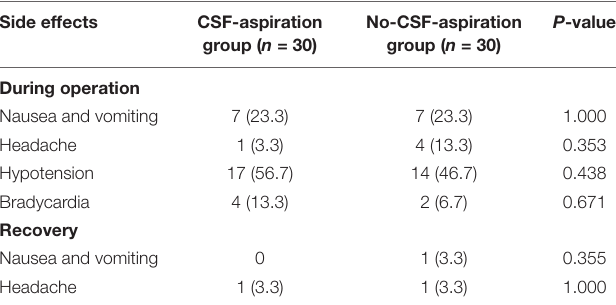
TABLE 5 | Comparison of SPA-related complications during operation and recovery in two groups of study.